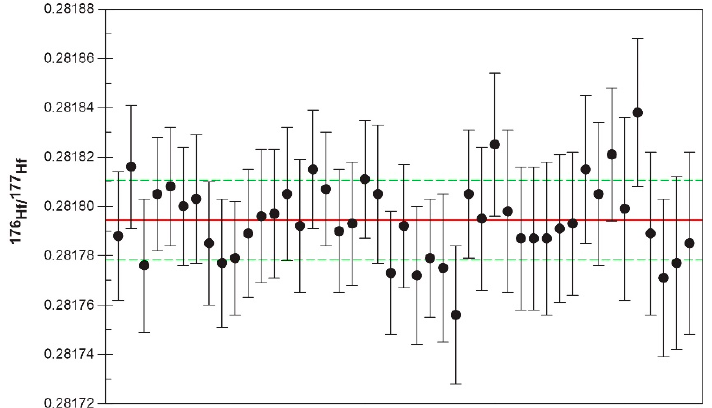
(Table S3) were also consistent with the solution chemistry-based data (0.00031 ± 0.00007; [48]). The LKZ-1 zircon showed little intra- and inter-grain variation in 176 Hf / 177 Hf (0.281794 ± 0.000016; Figure 6), 176 Lu / 177 Hf (0.000104 ± 0.000001), and 176 Yb / 177 Hf (0.00358 ± 0.00035) (n = 45). The 178 Hf / 177 Hf ratios were indistinguishable between 91500 (1.467289 ± 0.000059) and LKZ-1 (1.467286 ± 0.000057), with their 176 Lu / 177 Hf and 176 Yb / 177 Hf ratios showing a good positive correlation (R 2 = 0.97). The initial ε Hf values calculated from the 176 Hf / 177 Hf and 176 Lu / 177 Hf ratios and SHRIMP 206 Pb / 238 U age (572.6 Ma) varied narrowly and gave an average value of –22.0 ± 0.6. The 176 Hf / 177 Hf and 176 Lu / 177 Hf ratios did not show a clear trend (Figure S2).